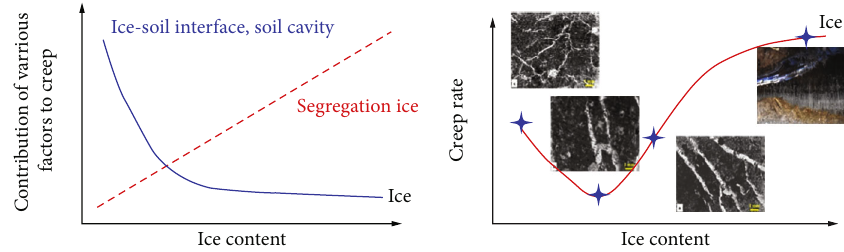
Figure 16: E ff ect of ice content on creep behavior of pile-frozen soil interface at a low